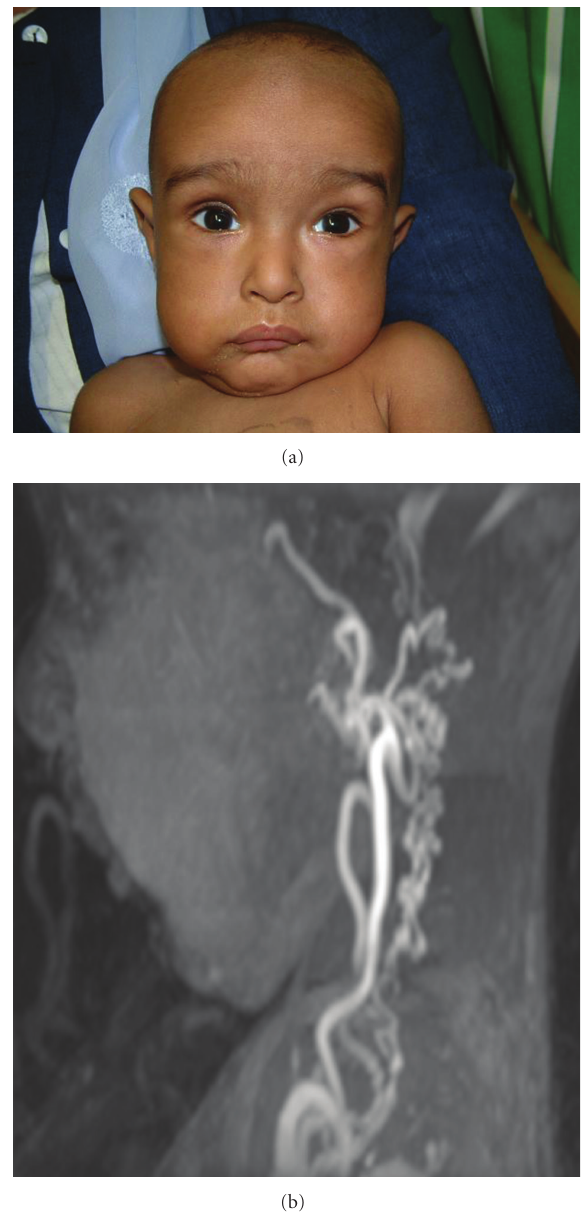
Figure 8: Patient characteristics of the Arterial Tortuosity Syn- drome. Longslender face with sagging cheeks and large ears (a). Marked arterial tortuosity